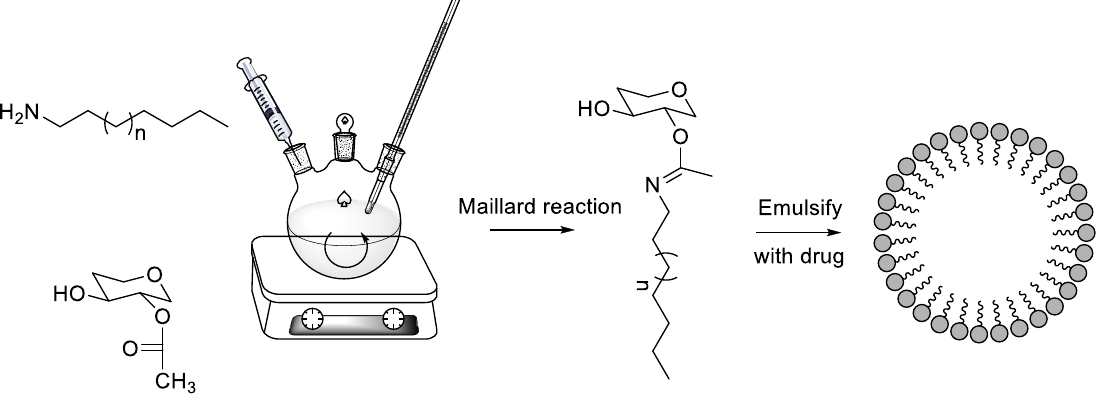
Figure 14. Application of the Maillard reaction in carbohydrate-modified preparations.